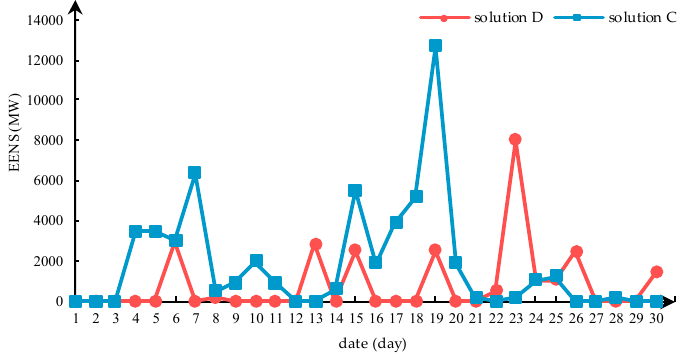
Figure 12. Comparison of the system reliability during the maintenance period in Hubei Province.